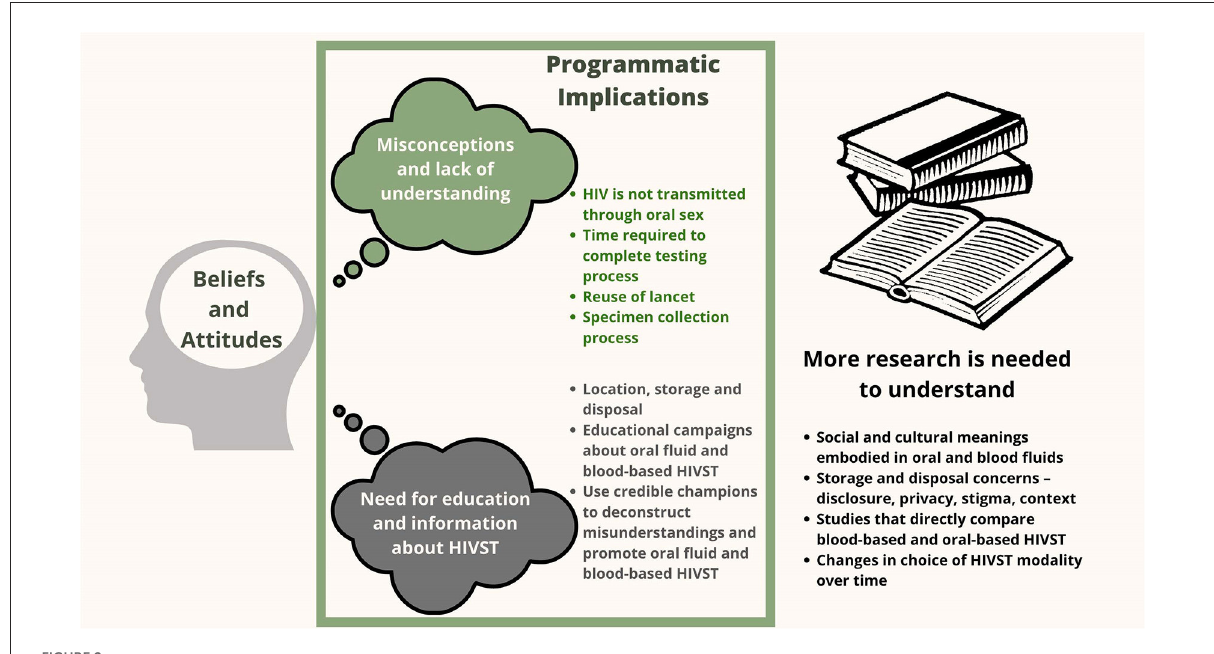
FIGURE2 Programmatic implications and the need for future